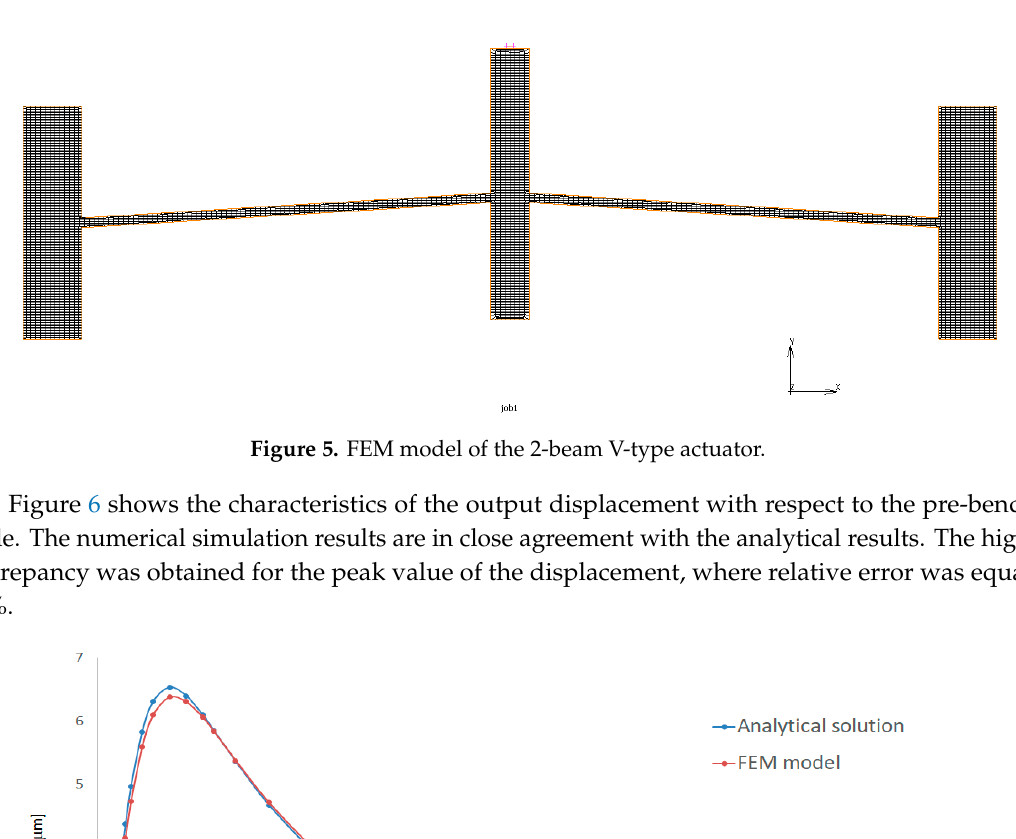
Figure 4. Symmetric beam pair of the V-type actuator.